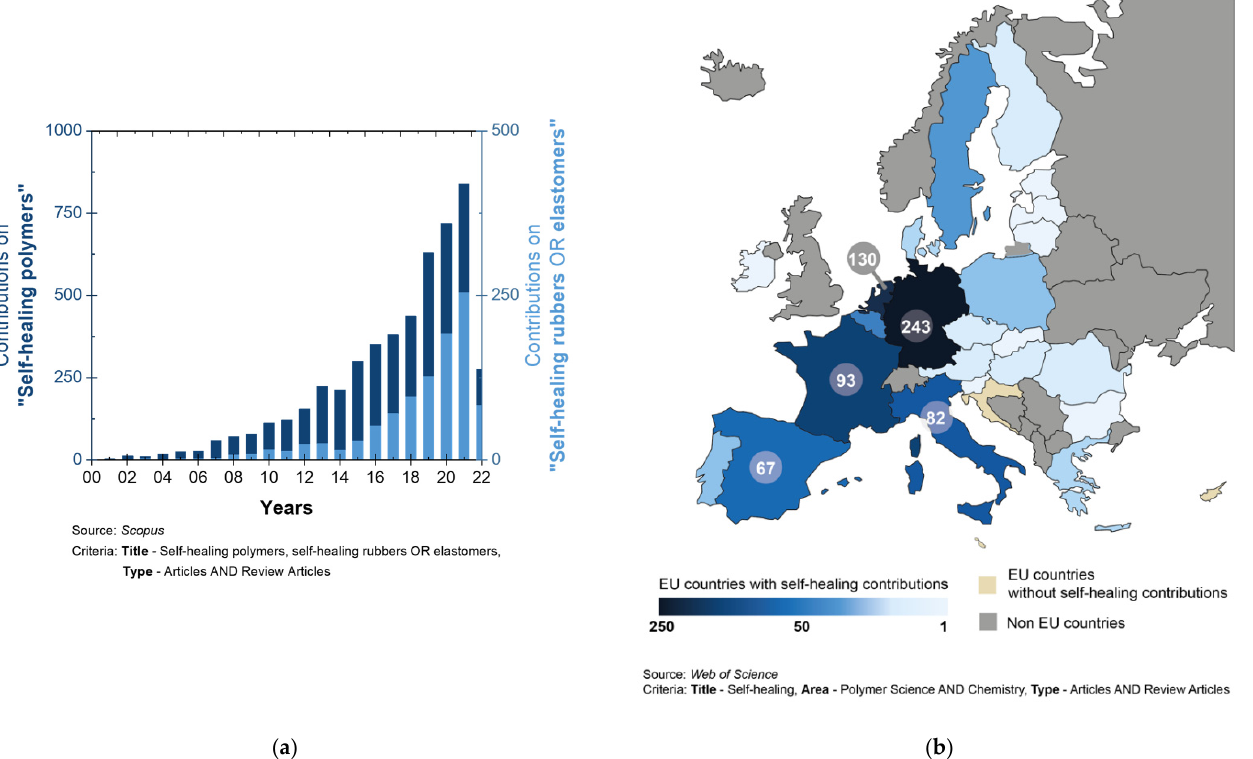
Figure 1. ( a ) Self-healing polymers and elastomers contributions in the 21st century, ( b ) Self-healing polymers contributions in European Union countries (complete United Kingdom data excluded). Source: Web of Science .